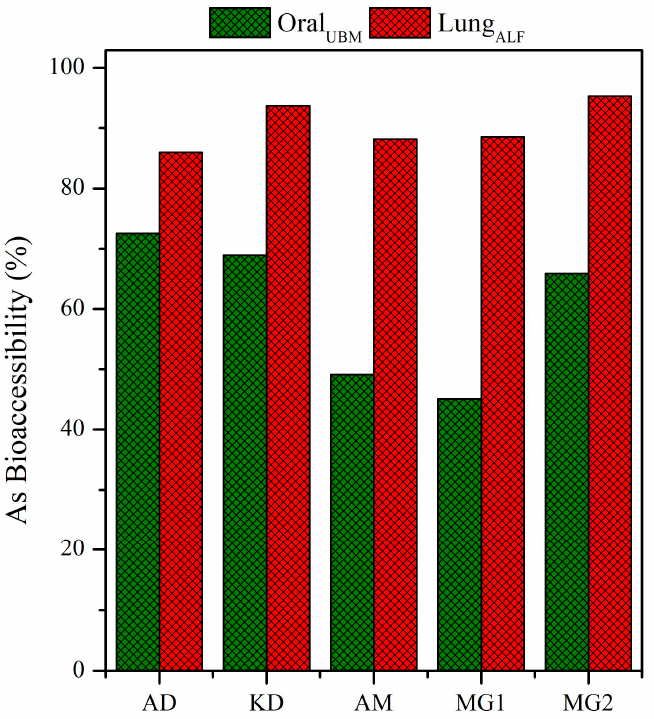
Figure 5. Arsenic bioaccessibility (%) of lignite fly-ash samples in gastric and lung fluids.